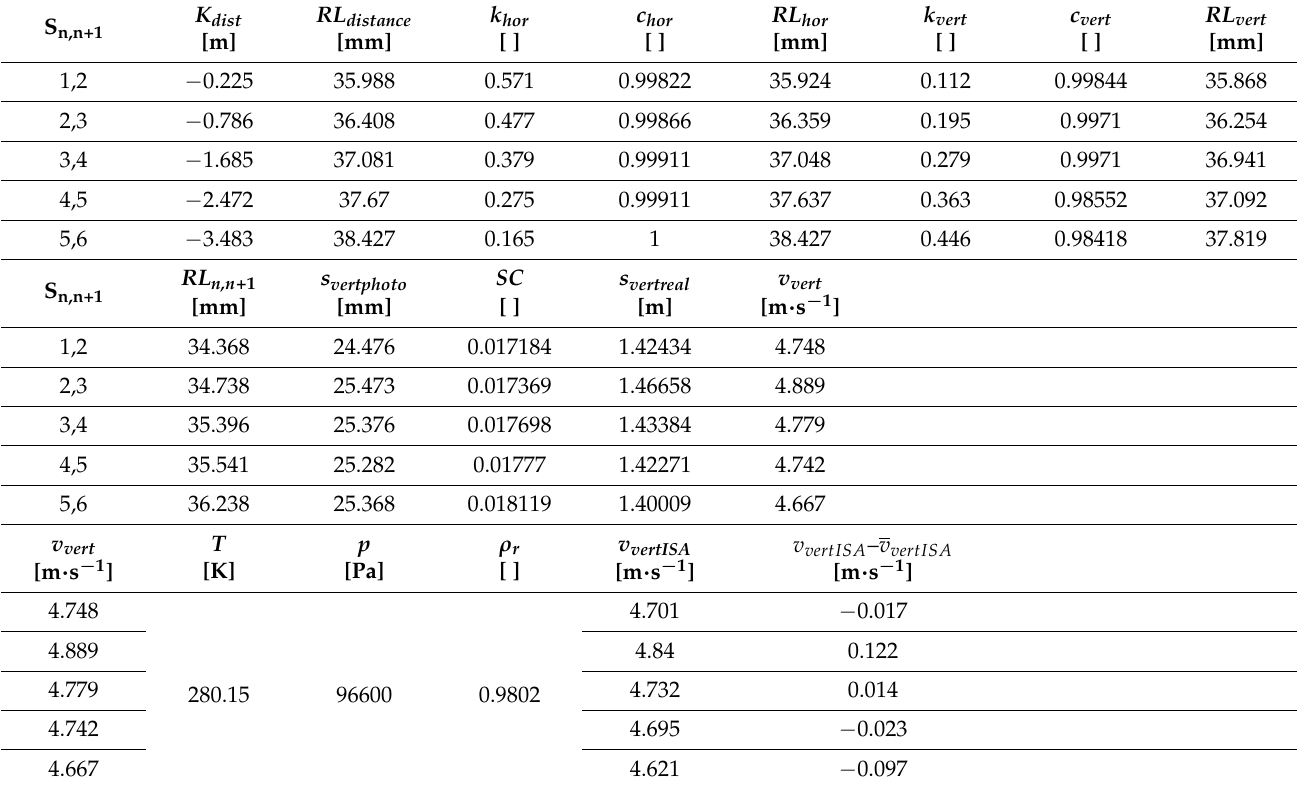
Table 3. v vertISA using the photo-optical method—test jump number